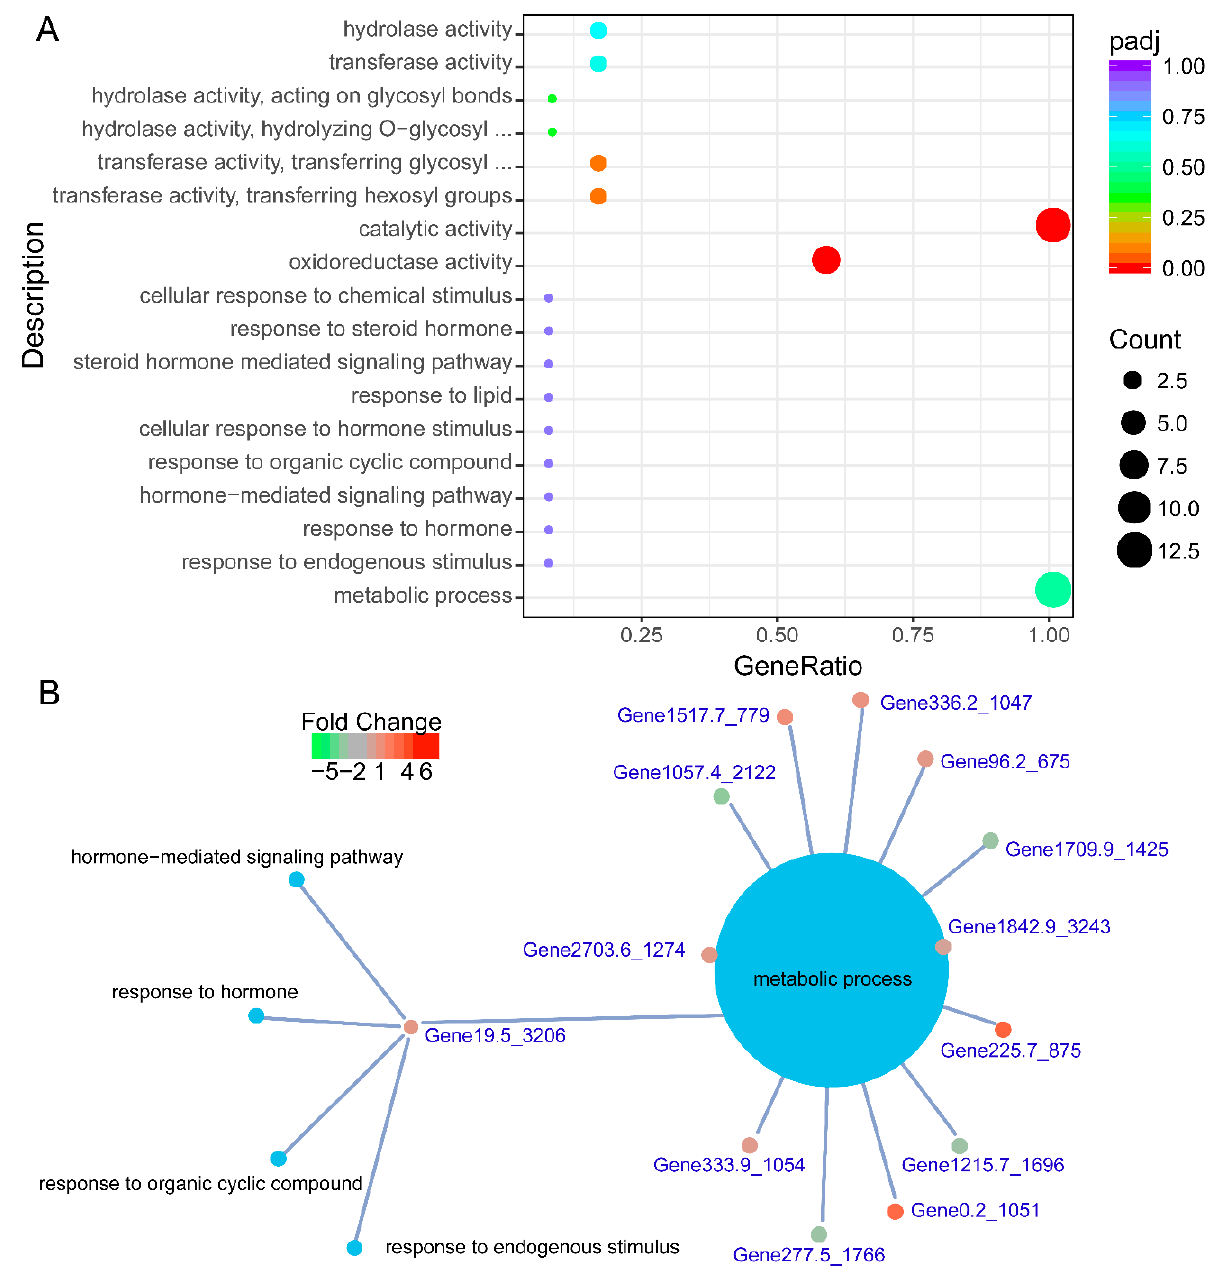
Figure 4. Gene Ontology (GO) enrichment of DEGs in dauer juveniles (J IV ) of Bursaphelenchus xylophilus promoted by β -pinene. ( A ) Scatter plots of GO term enrichment of DEGs in J IV promoted by β -pinene. X-axis indicated the ratio of the number of DEGs in this GO term/number of total DEGs. Y-axis indicates the GO term. The size of the point indicates the number of DEGs in this GO term. The color, from red to purple, means the p -value of significance. ( B ) CNET plots of the GO term enrichment of the 00EGs in J IV promoted by β -pinene. The color, from green to red, means the fold change of the DEGs.